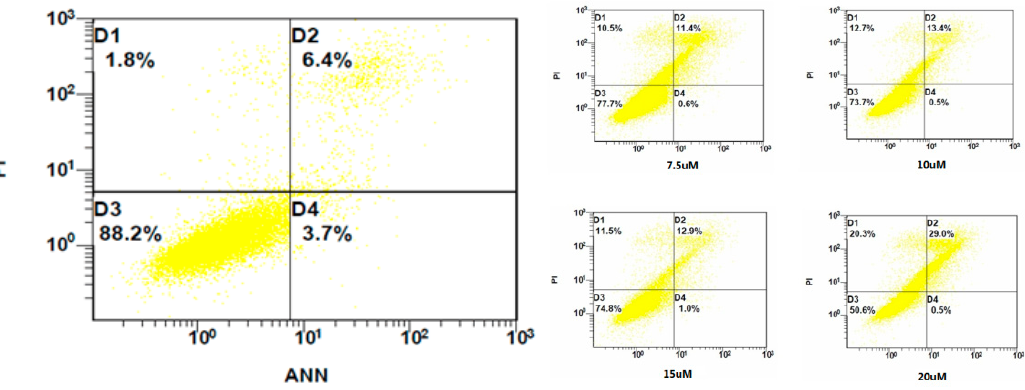
Figure 2. Flow cytometry results.